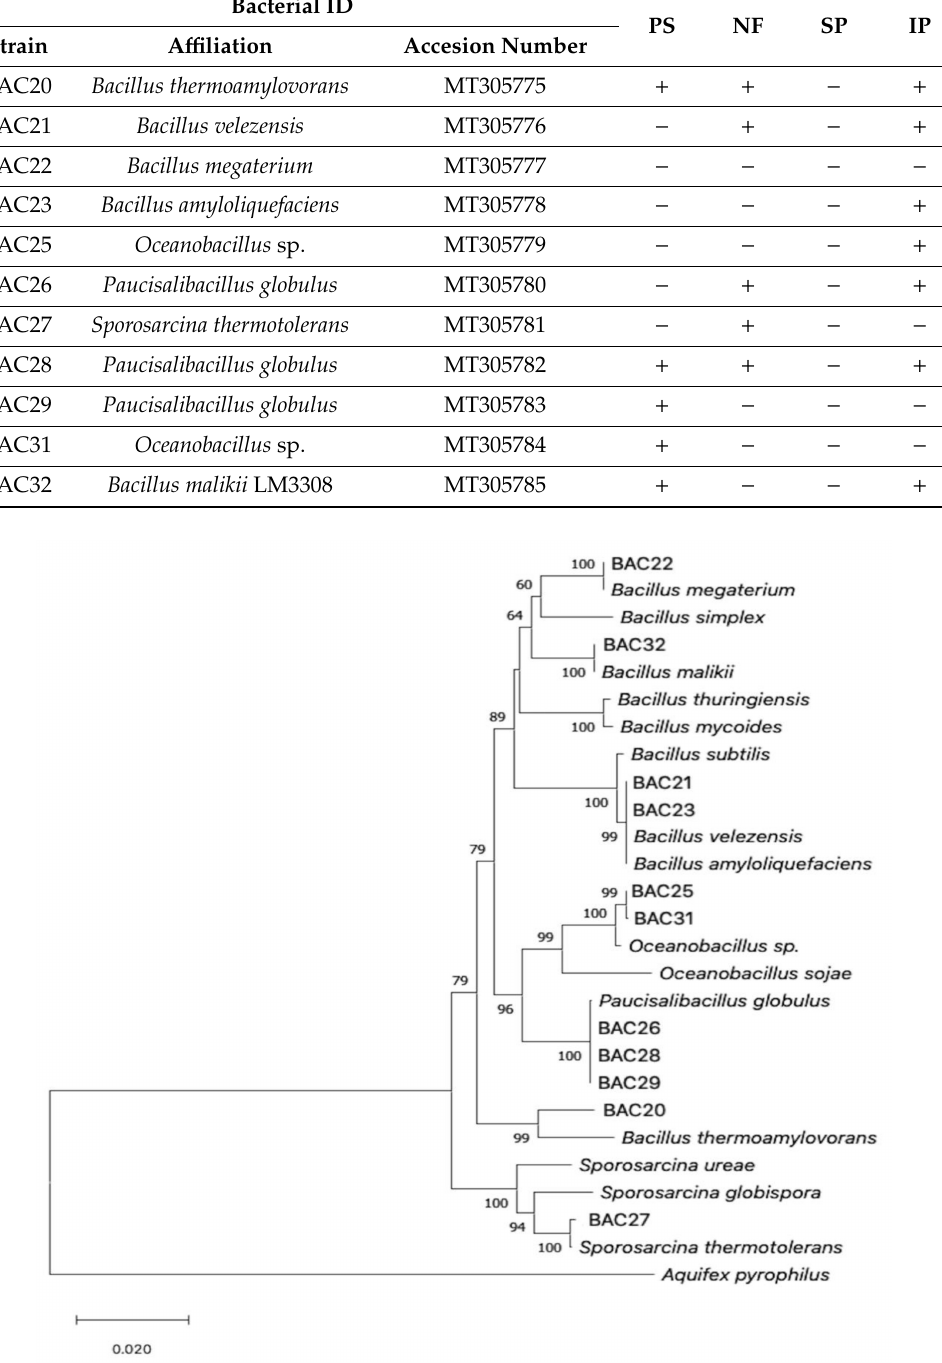
Figure 3. Comparative analysis of partial 16S rRNA gene sequences of the isolates obtained from SOA. The phylogenetic tree was inferred using the neighbor-joining method with a bootstrap analysis of 1000